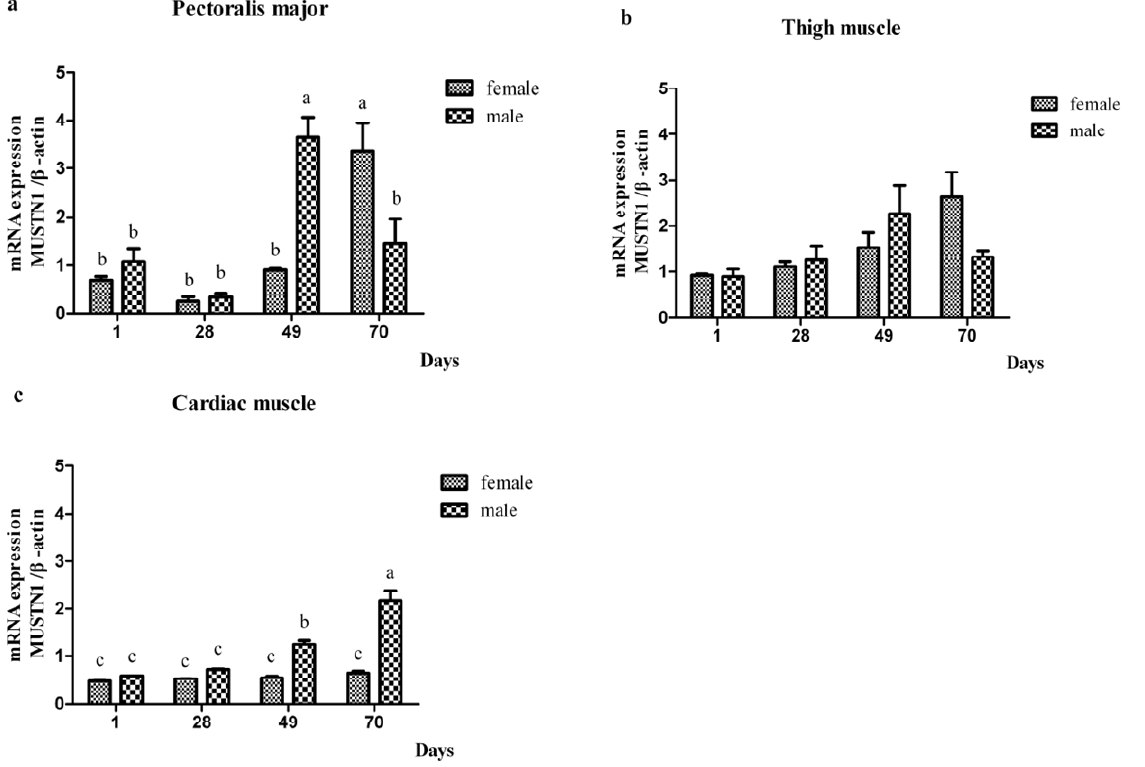
Figure 2. The abundance of MUSTN1 mRNA among age by sex combinations within single tissue. ( a ) The abundance of MUSTN1 mRNA in pectoralis major; ( b ) The abundance of MUSTN1 mRNA in thigh muscle; ( c ) The abundance of MUSTN1 mRNA in cardiac muscle. Bars without the same letter within single tissue of sex × age indicate differences significant at p < 0.05. Data are presented as mean ± SD ( n = 4).